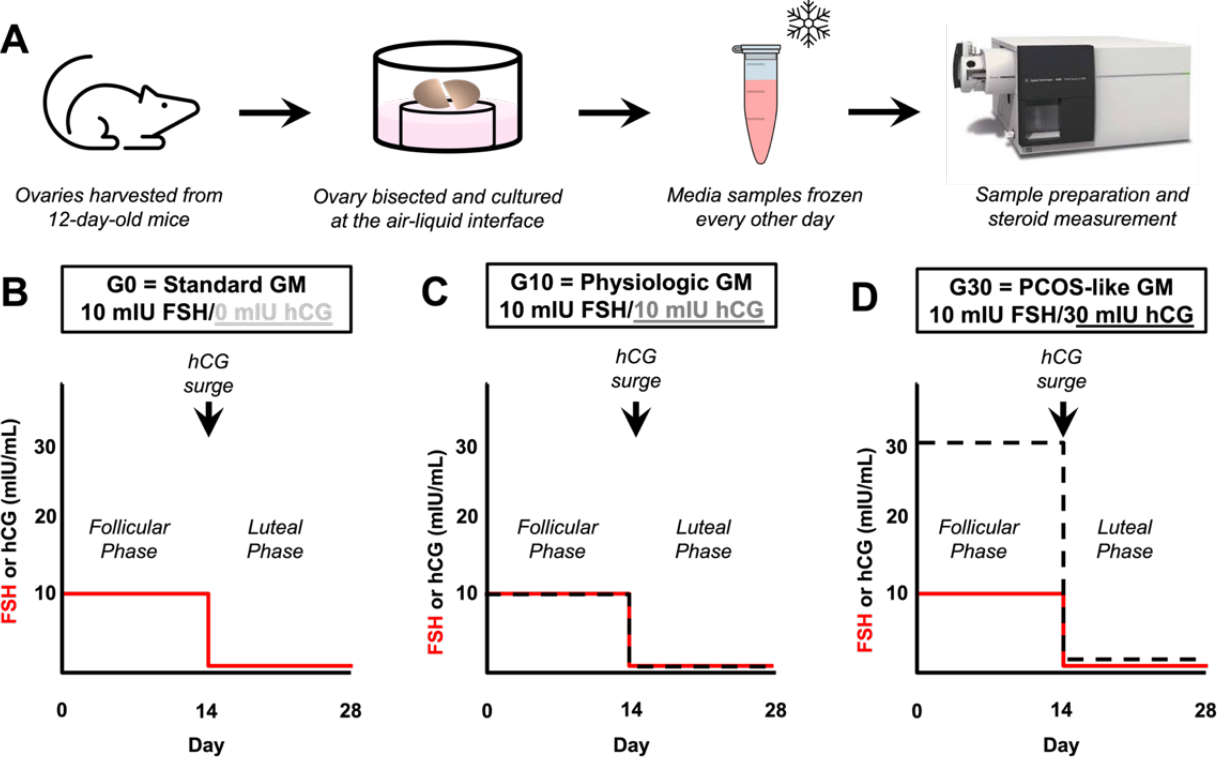
Figure 1. Schematic of experimental design. ( A ) Schematic diagram of experimental workflow. Ovaries were harvested from 12-day-old CD-1 mice, bisected, and cultured at the air–liquid interface. Media samples were obtained every other day and frozen until analysis. At the end of the study, samples were thawed, prepared, and analyzed by mass spectrometry. Diagrams of gonadotropin (FSH and hCG) concentrations during the 28-day culture for the ( B ) “G0,” standard growth media (GM) condition with 10 mIU/mL FSH during the follicular phase (day 1–14) and 1 mIU/mL FSH during the luteal phase (day 15–28), ( C ) “G10,” physiologic GM condition with 10 mIU/mL FSH and 10 mIU/mL hCG during the follicular phase (day 1–14) and 1 mIU/mL FSH and 1 mIU/mL hCG during the luteal phase (day 15–28), and ( D ) “G30,” PCOS-like GM condition with 10 mIU/mL FSH and 30 mIU/mL hCG during the follicular phase (day 1–14) and 1 mIU/mL FSH and 3 mIU/mL hCG during the luteal phase (day 15–28). For all groups ( B – D ) ovulation was triggered on day 14 with a 16–18 h surge of hCG at a concentration of 1.5 IU/mL. FSH = follicle stimulating hormone, hCG = human chorionic gonadotropin .